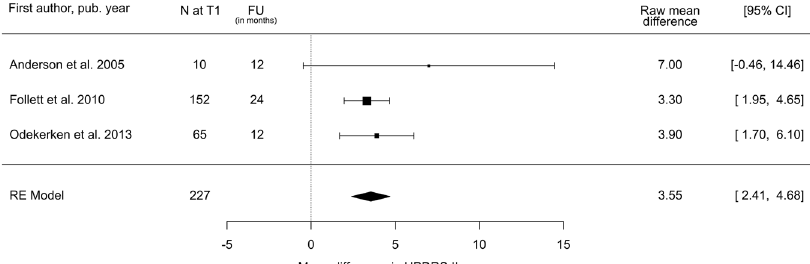
Fig. 2 Estimated decrease in total UPDRS II score following GPi-DBS. Postoperative stimulation-ON/medication-OFF vs. preoperative OFF- medication state: UPDRS II Mean Difference. N = number of subjects at follow-up; FU = follow-up time; CI = con fi dence interval; RE Model = random-effects Table 3). According to our literature search criteria, only fi ve GPi